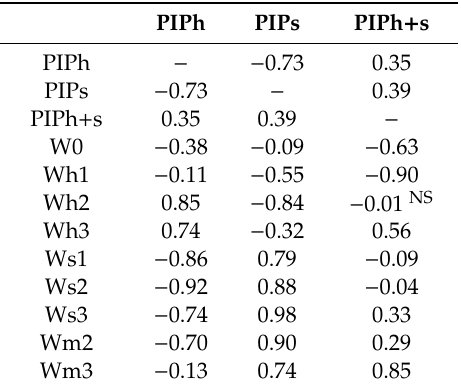
Figure 8. Age and sex dependency of the percentage of each word category codes for the symbolic dynamics of four consecutive ∆ NN. The definition of word category codes was explained in Table 1.